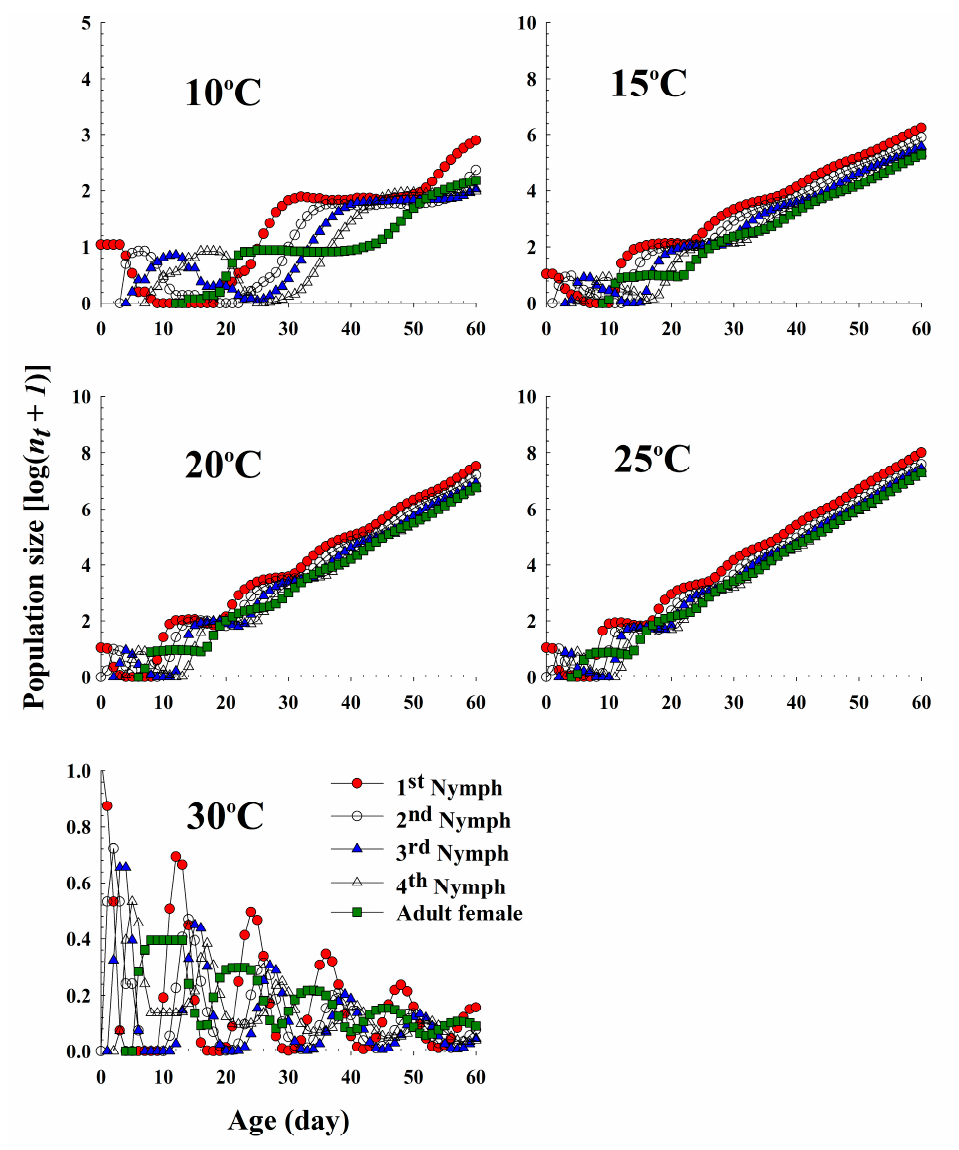
Figure 6. The population growth projection of Acyrthosiphon pisum in response to different temperature conditions beginning with an initial population of 10 newly born nymphs.